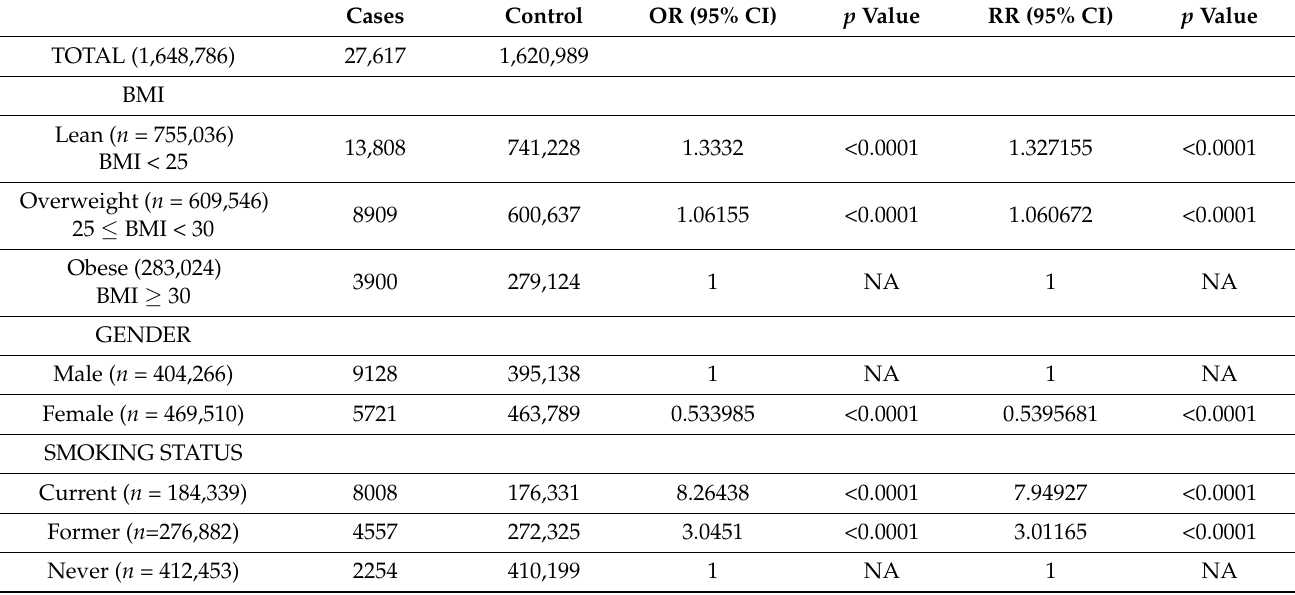
Table 1. BMI (body mass index) and lung cancer risk. Irrespective of gender and smoking status, higher BMI correlates with lower lung cancer